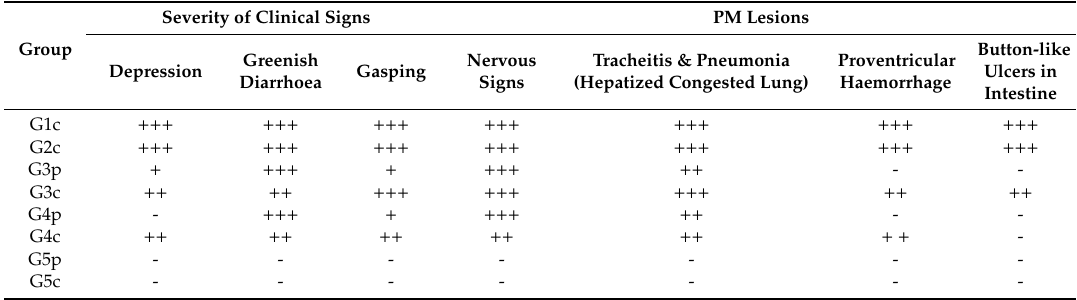
Table 2. The clinical and PM lesion sign scores of experimentally-infected